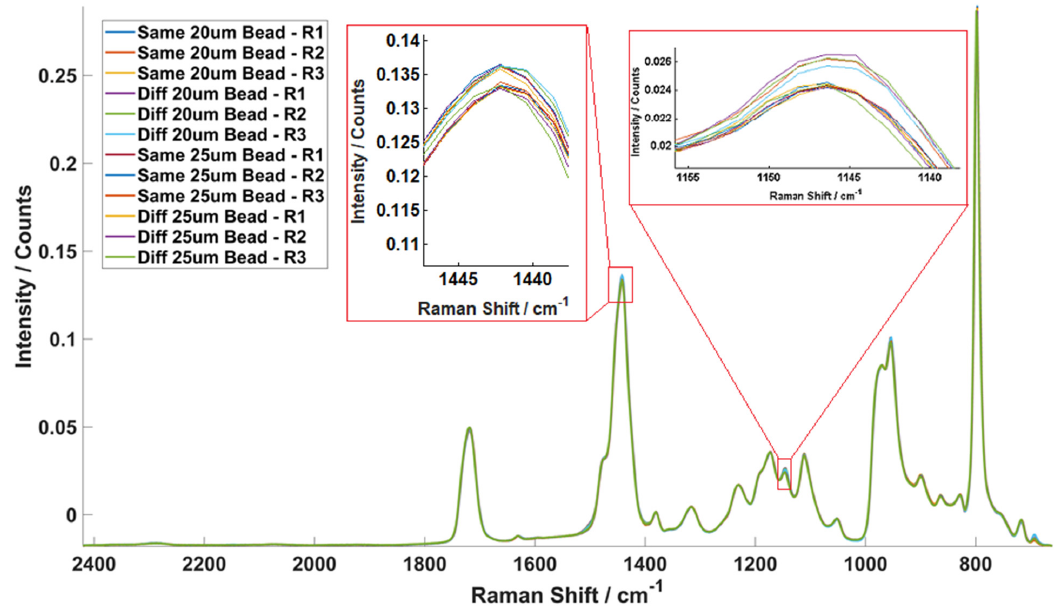
Figure 5. System repeatability test results and the corresponding statistical test results showing the mean spectra of all 12 polystyrene bead experiments. All 12 mean spectra generated from 540 single bead spectra overlay with each other in the figure, showing that there are negligible differences between the Raman spectra measured in different situations. The calculated relative standard deviations of each case and the calculated average RSD is only 0.94%. The inserts show the peaks at 1442 and 1145 cm − 1 in order to better highlight the individual